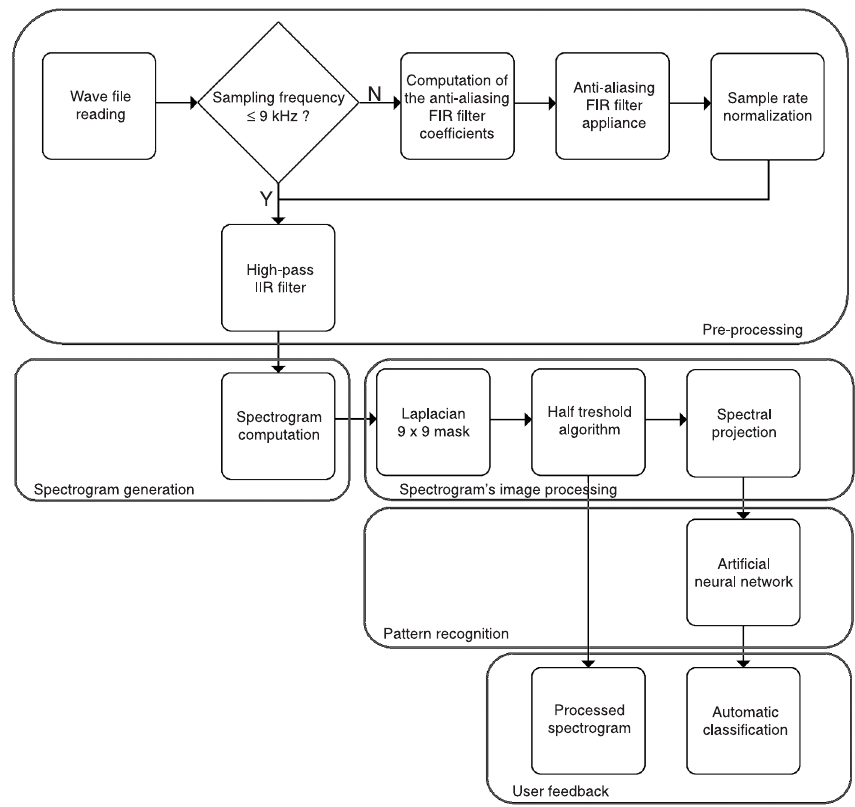
Figure 1. Flowchart of the soft- ware described here to imple- ment the proposed methodology for automatic wheezing recogni- tion. FIR = finite impulse re- sponse digital filter; IIR = infinite impulse response digital